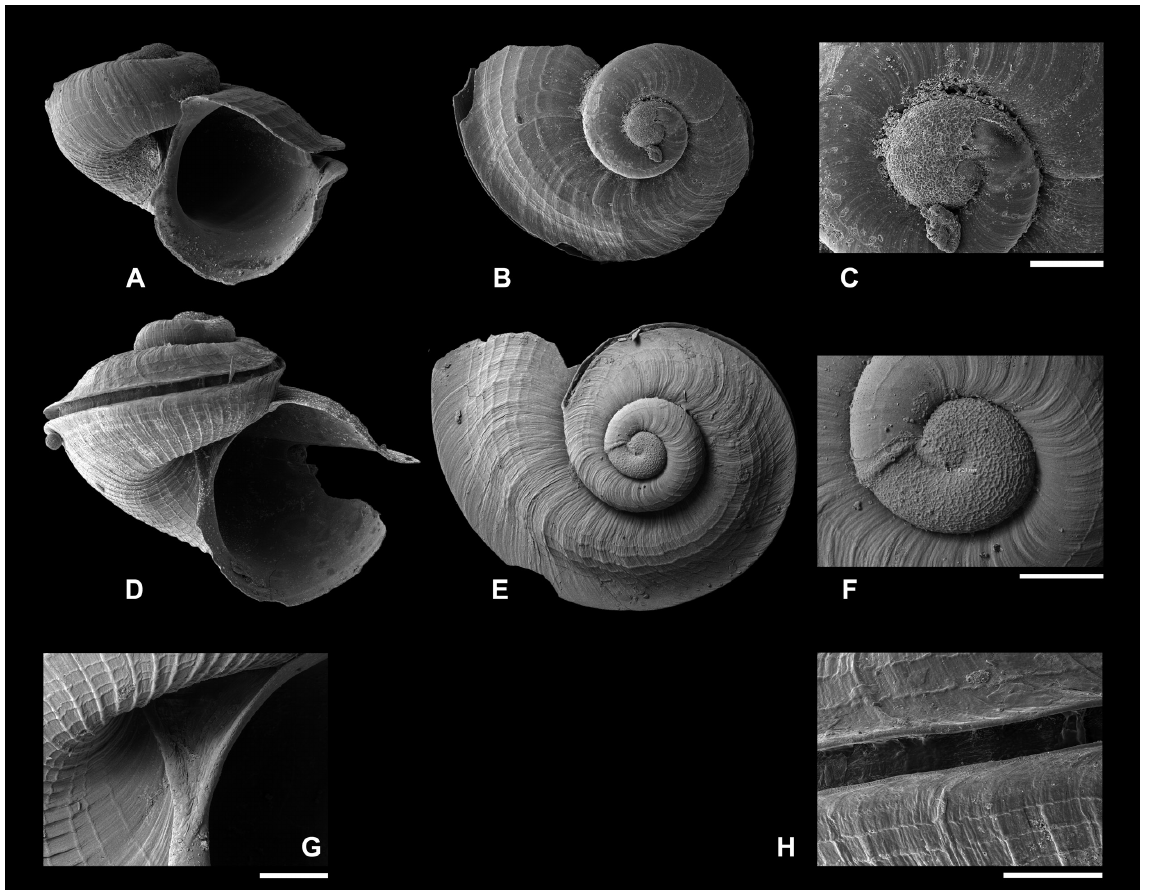
Fig. 11. Anatoma paucisculpta sp. nov. A–C . Paratype (SMF 358993), INDEX19_104RO (I19_Ma_91). H 0.77 mm, W 0.99 mm, Ha 0.61 mm, Wp 0.20 mm. D–H . Holotype (SMF 358992), INDEX15_62R (I15_Ma_169), H 1.03 mm, W 1.20 mm, Ha 0.70 mm, Wp 0.21 mm. Scale bars: 0.1